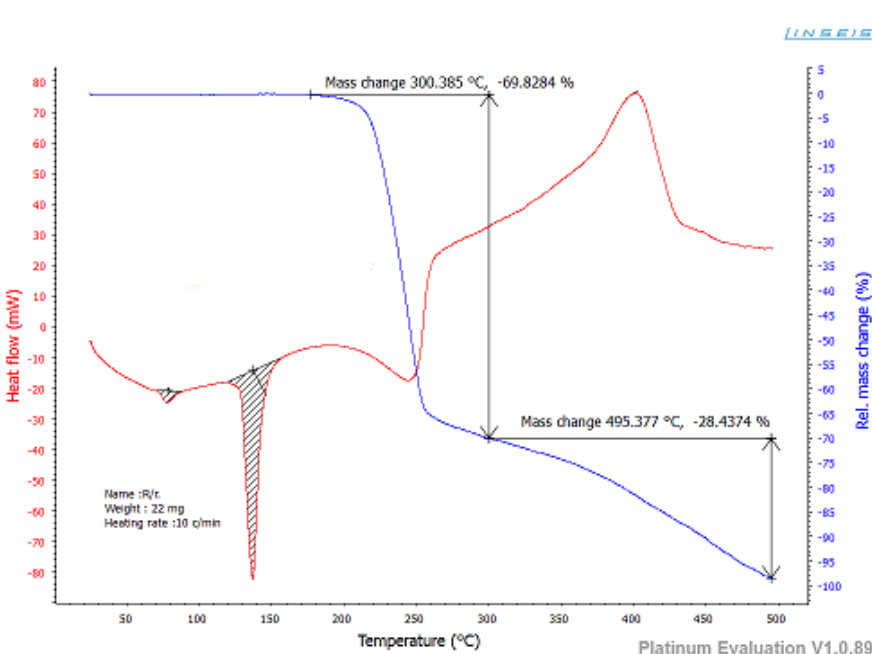
Figure 8: TG and DSC curves for pyrogallol thermal decomposition (heating rate